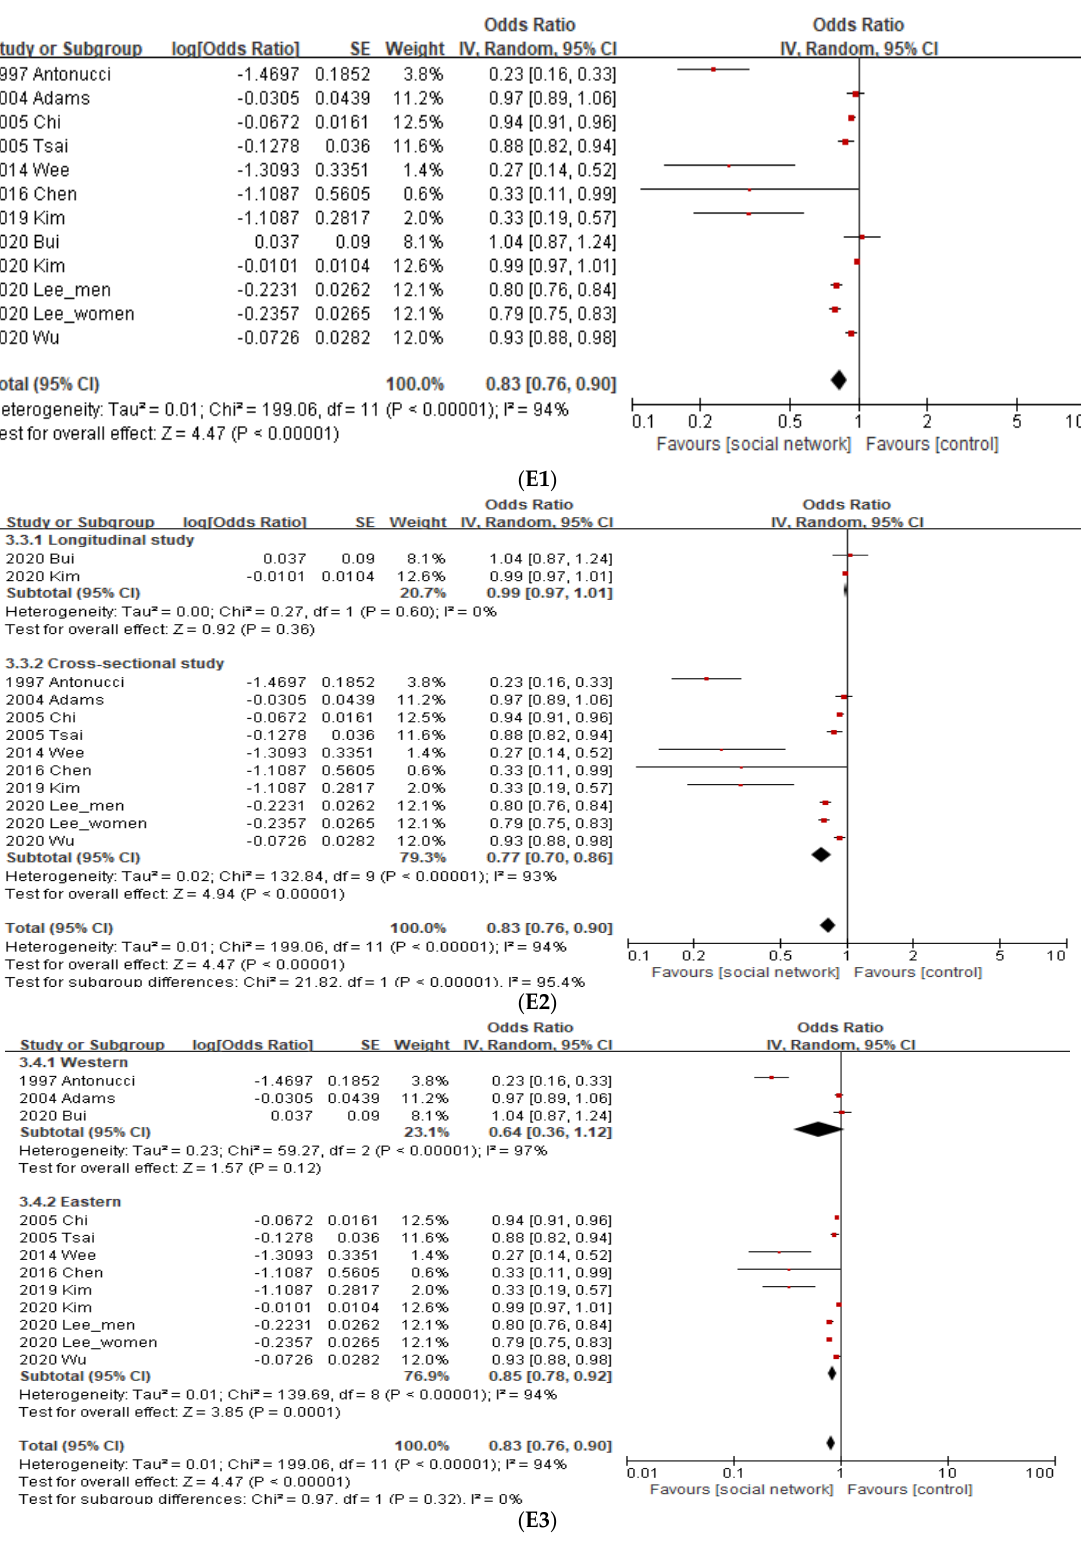
Figure 3. Meta-analysis. ( A ). Social support. ( B ) Social participation. ( C1 ) Social participation. ( C2 ). Subgroup analysis of social participation by study design. ( C3 ). Subgroup analysis of social participation by published continents. ( D1 ). Social network. ( D2 ). Subgroup analysis of social network by study design. ( E1 ). Social network. ( E2 ). Subgroup analysis of social network by study design. ( E3 ). Subgroup analysis of social network by published continents.